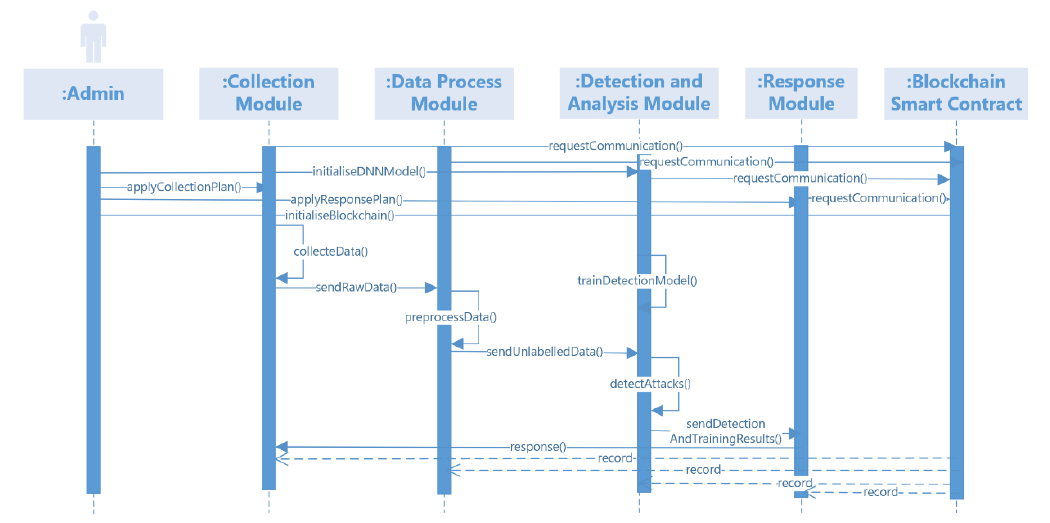
Figure 4. Smart, efficient, secure, and scalable (SESS) system sequence diagram.